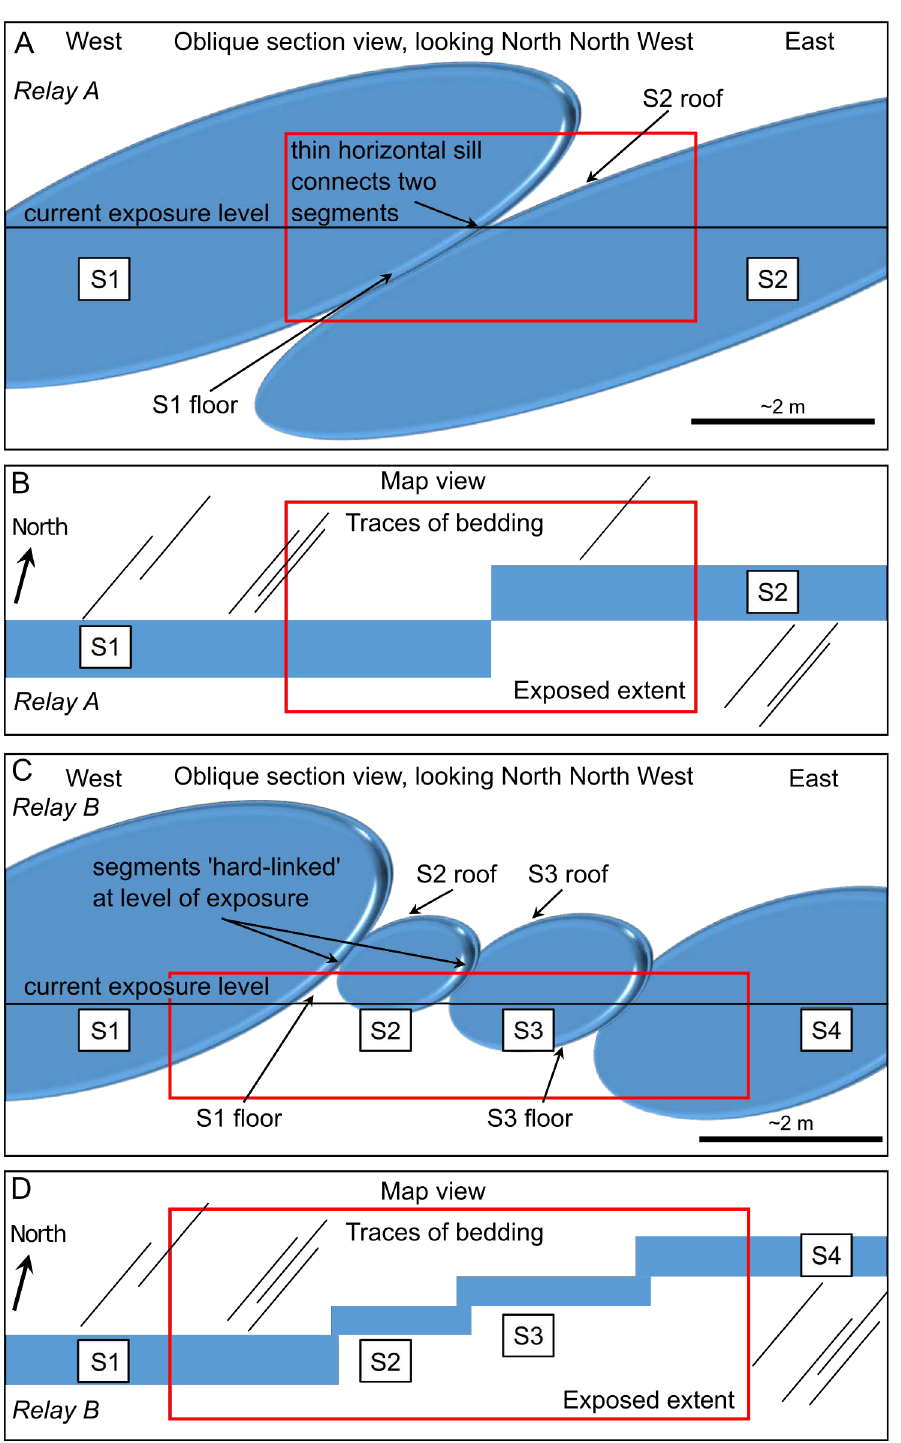
Figure 13: Summary models of field observations from the relays and their interpretations. [A]–[B] Schematic idealised section and map view of Relay A, with the segments modelled as two thin ellipsoidal sheets, oriented with their longest axes inclined to the horizontal, and steeply dipping to the South. In the section view, S2 is further back (North) than S1. The red box denotes the region covered by Figure 6. The location of the thin connecting sill (not shown) is marked. The close juxtaposition of a shallow dipping floor and a roof contact is clearly shown, at the current level of exposure. [C]–[D] Schematic idealised section and map view of Relay B, with the segments modelled as four thin ellipsoidal sheets, oriented with their longest axes inclined to the horizontal, and steeply dipping to the South. In the section view, segments S2–S4 step back (to the North). The red box denotes the region covered by Figures 7 and 8. The close juxtaposition of multiple shallow dipping floor and roof contacts is clearly shown, at the current level of